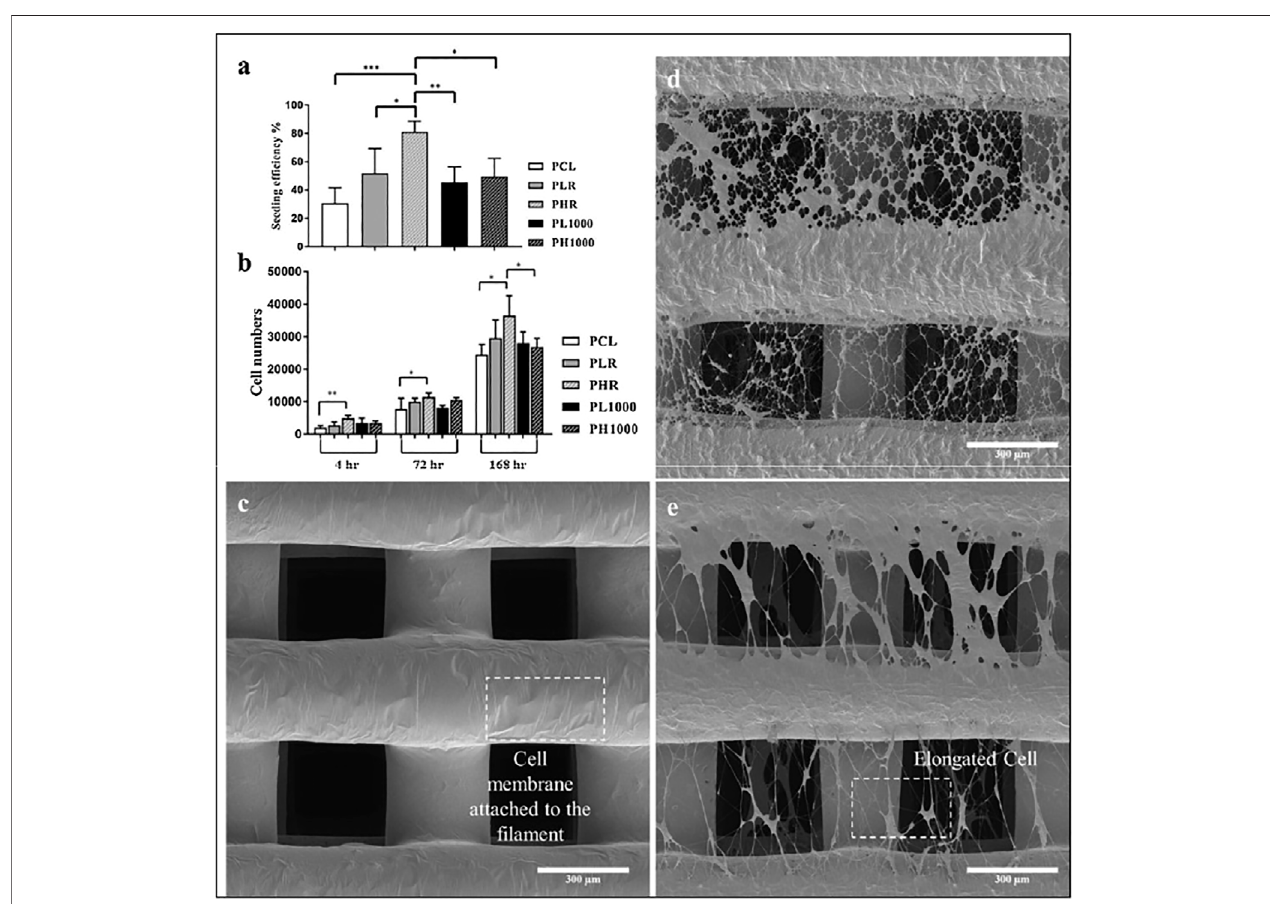
FIGURE2|(A) hADSCsseedingef fi ciencyofthefollowingtypesof3DprintedPCLscaffolds(4 hofincubation):withoutelectrospun fi bers (PCL);withelectrospun fi bers deposited at 0 rpmfor 45 s (PLR); with electrospun fi bers deposited at 0 rpmfor 120 s(PHR);with electrospun fi bers deposited at 1,000 rpm for 120 s(PL1000); withelectrospun fi bers deposited at 1,000 rpmfor 360 s(PH1000). (B) Number ofhADSCs detected on the fi vetypes ofscaffolds at 4,72and 168 hofcell culture test. Scanningelectron microscopy (SEM) images of (C) PCL scaffold, (D) PHRscaffold and (E) PH1000 scaffoldafter 1 day ofcellculture. The SEMimages show cells attached on the structures of the scaffolds and the alignment of the cytoskeleton when aligned nano fi bers are present. Reprinted from (Huang et al., 2020).